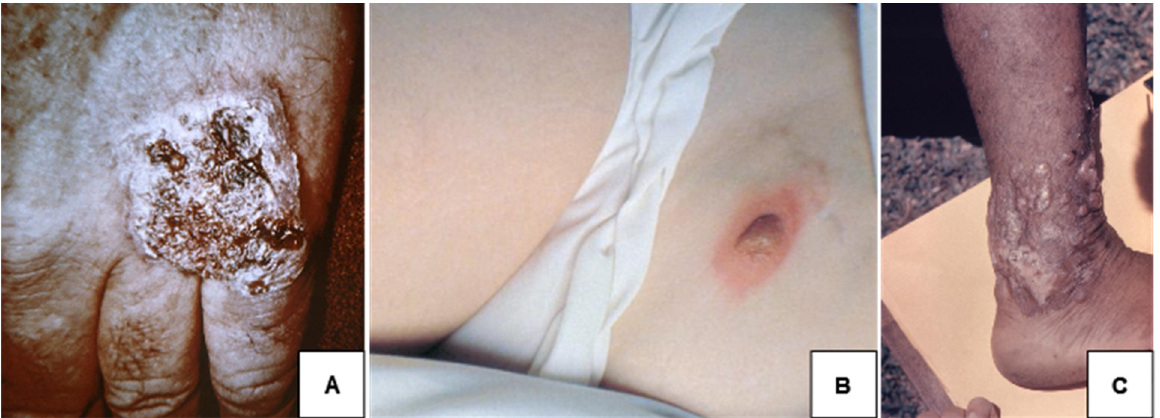
Figure 4. Cutaneous blastomycosis. ( A ) Verrucous blastomycosis; ( B ) nodular cutaneous blastomy- cosis with bulla formation; ( C ) keloidal blastomycosis. All images were obtained through the CDC Public Health Image Library (https://phil.cdc.gov (accessed on 1 August 2022)).